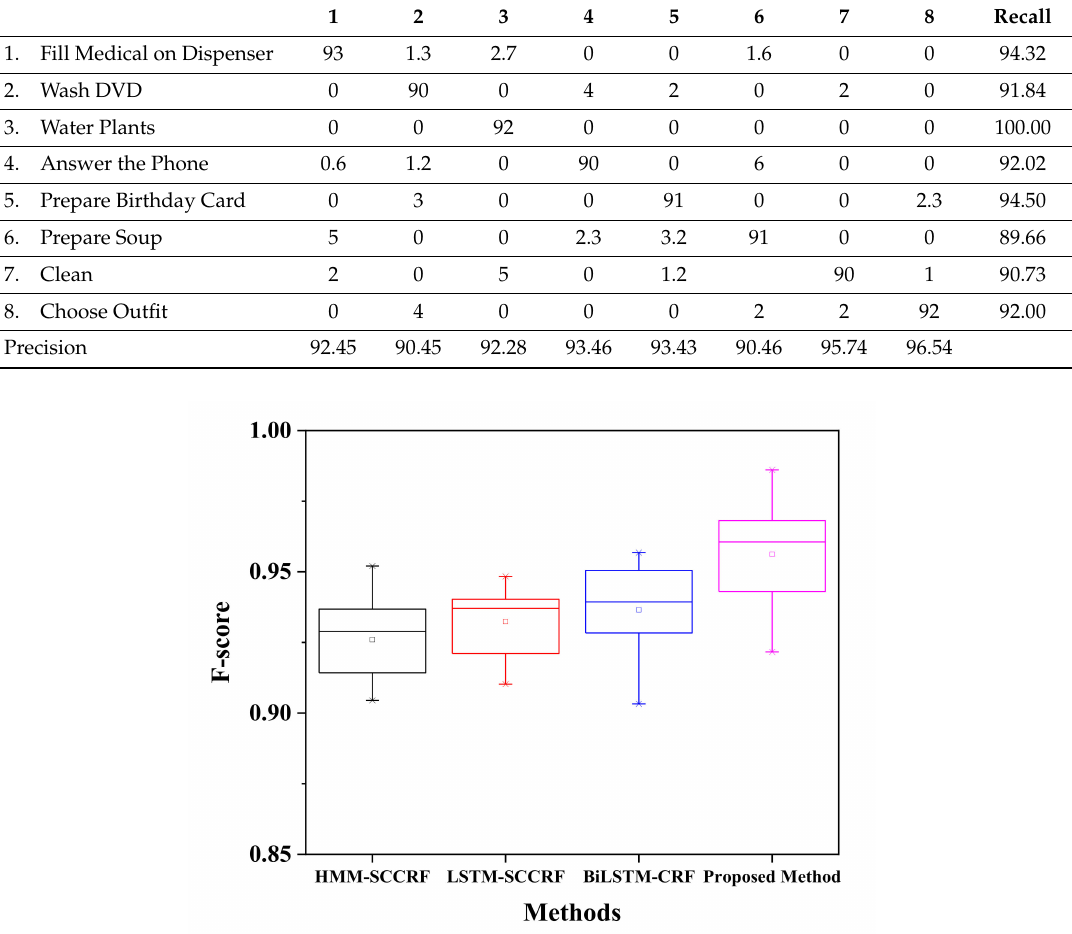
Figure 15. F-score comparison on